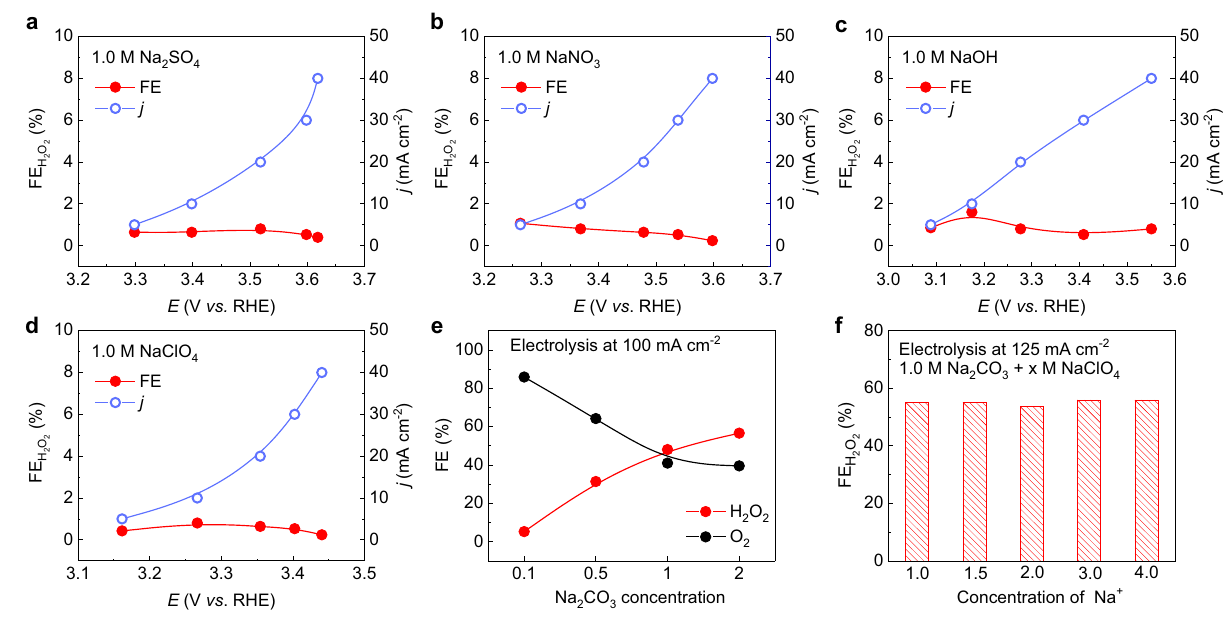
Fig. 2 Impacts of anion species and anion/cation concentrations on 2e − -WOR. a – d I – V curves and H 2 O 2 FEs of FTO catalyst using 1.0 M Na 2 SO 4 , 1.0 M NaNO 3 , 1.0 M NaOH, and 1.0 M NaClO 4 , respectively. The H 2 O 2 FEs in these electrolytes were lower than 2%, indicating there are no promotion effects for H 2 O 2 formation using these anion species. e Dependence of H 2 O 2 and O 2 selectivity on Na 2 CO 3 concentration at 100 mA cm − 2 . The H 2 O 2 FE was increased with increased Na 2 CO 3 concentration, while the FE of side product O 2 was correspondingly decreased, indicating that Na 2 CO 3 could be directly involved in the 2e − -WOR process. f H 2 O 2 FE in 1.0 M Na 2 CO 3 with different concentrations of NaClO 4